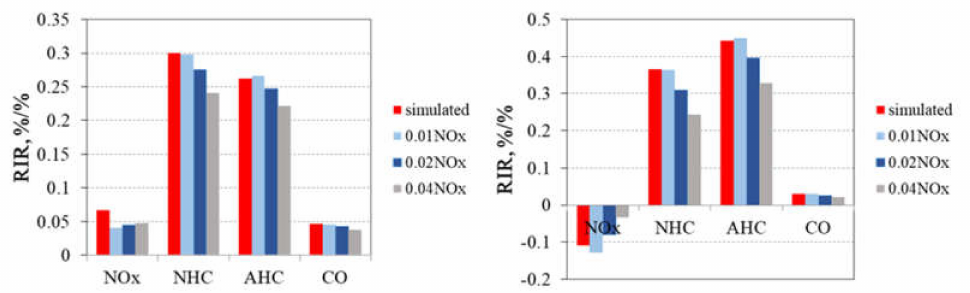
Figure 7. The average RIR values for NO x , NHC, AHC, and CO for simulated gaseous nitrous acid (HONO) (red bar) and HONO concentrations assumed as 1% (pale-blue bar), 2% (dark-blue bar), and 4% (gray bar) of NO X concentrations at the DSH site (left panel) and the PD site (right panel).